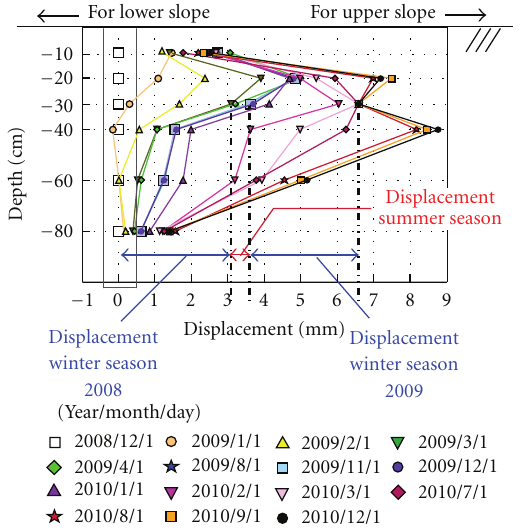
Figure 12: Changes in displacements using clinometer (multiple inclination transducers) during 2